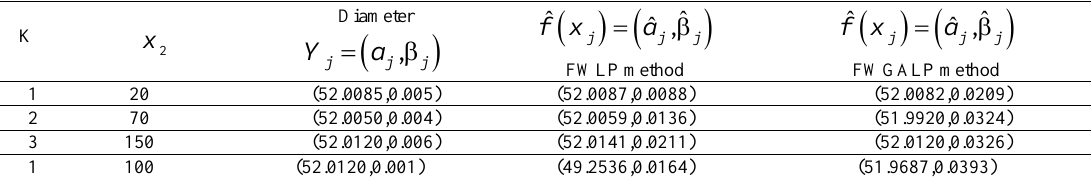
Table 7. Measured workpiece diameter and fuzzy outputs obtained using different methods for Example 2.